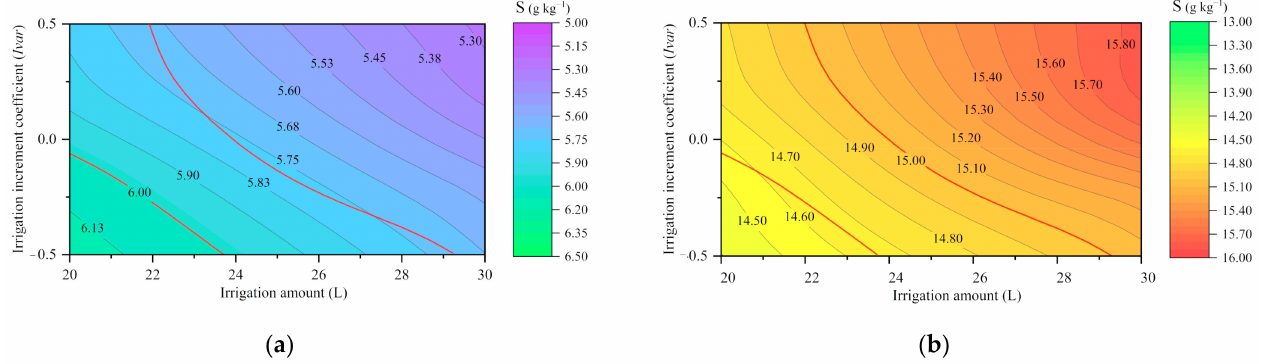
Figure 13. Soil salinity under different total irrigation amounts, with Ivar , at the end of scenario. ( a ) Soil salinity in the root zone; ( b ) soil salinity in the un-mulched soil